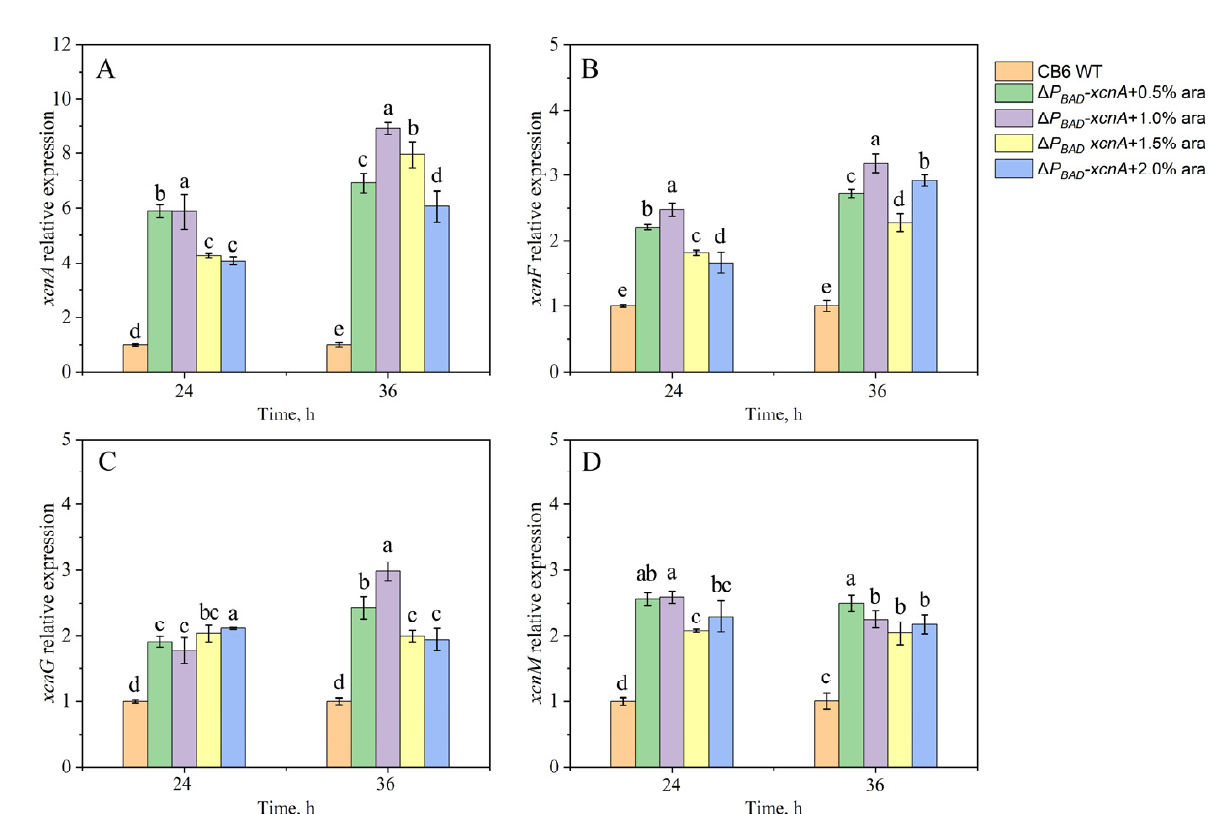
Figure 4. ( A ) xcnA relative expression ( B ) xcnF relative expression ( C ) xcnG relative expression ( D ) xcnM relative expression. Relative transcription levels of the biosynthesis and conversion related genes of Xcn1 ( xcnA , xcnF , xcnG , and xcnM ) were measured by qRT-PCR; error bars represent the standard deviation of three independent replicates. Data were subjected to the Duncan ANOVA test, columns labelled with different lowercase letters were significantly different at p ≤ 0.05.